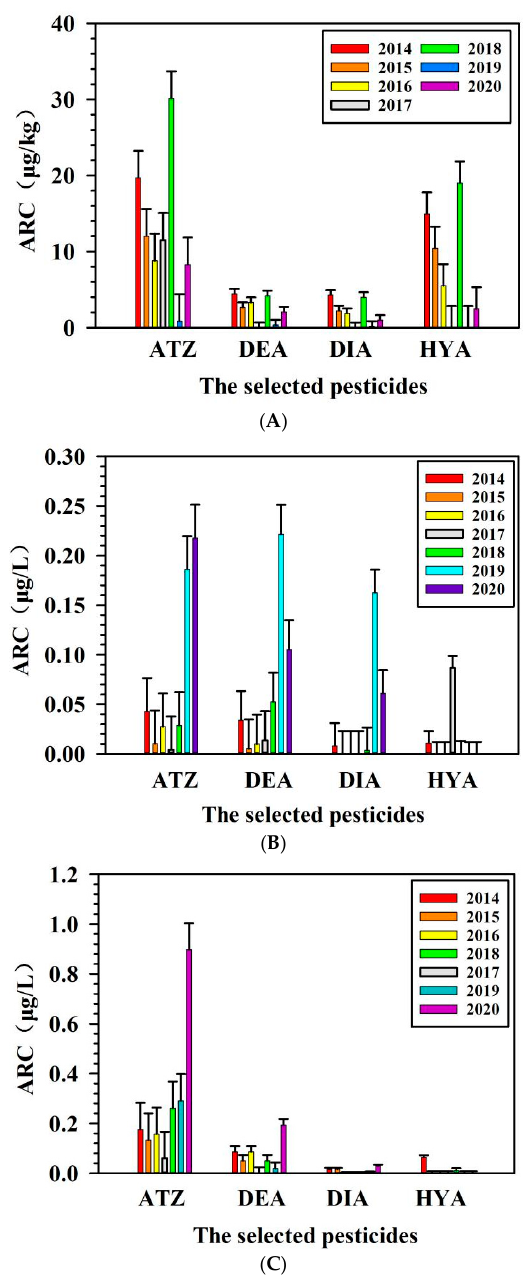
Figure 3. Average residual concentration of the analytes detected in ( A ) soil; ( B ) ground water; ( C ) surface water.